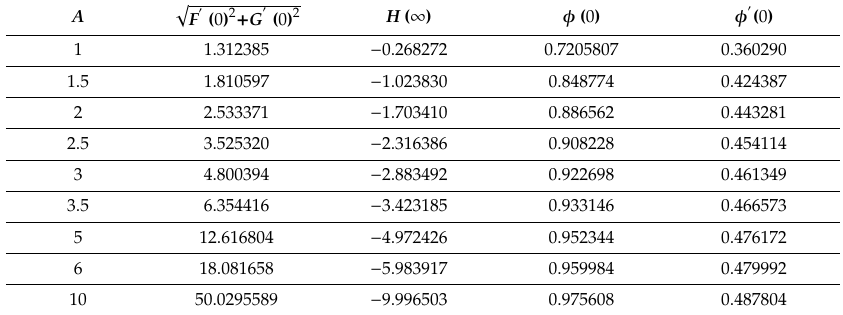
Table 3. Values of wall skin friction, volumetric flow rate, wall concentration, and wall concentration gradient for di ff erent values of A when K = 0.5 = K s and Sc = 2.